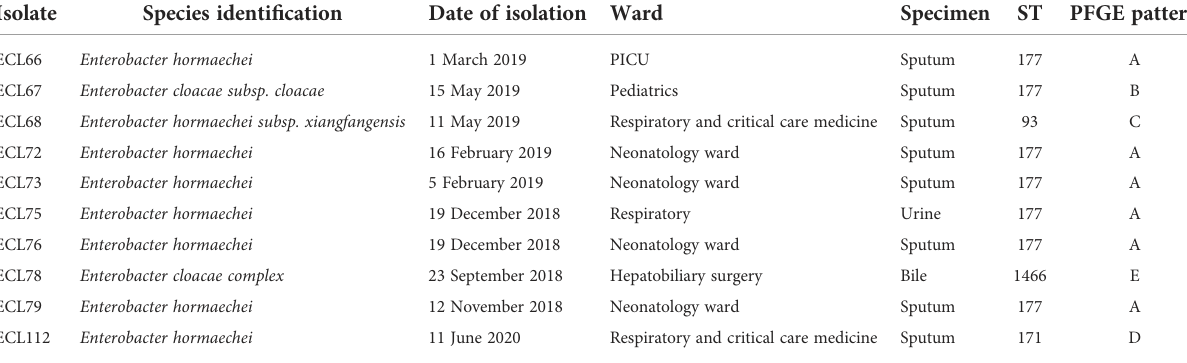
TABLE 1 Microbiological and molecular characteristics of Enterobacter cloacae strains. Isolate Species identi fi